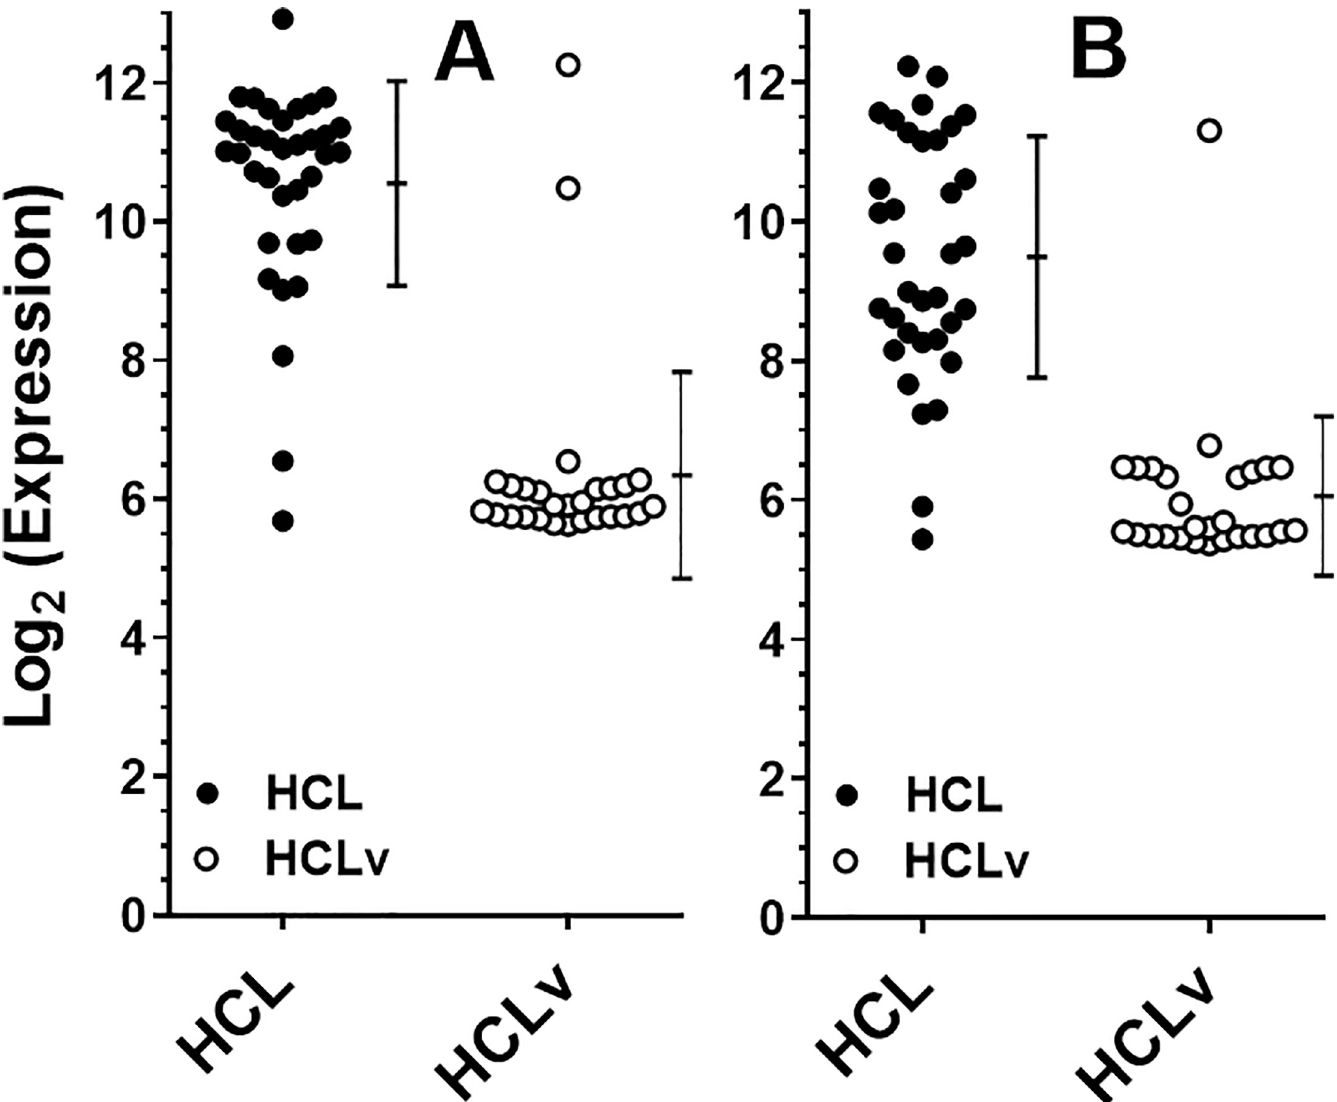
Fig 1. Microarray expression of Myf6 in HCL ( ● ) and HCLv ( � ) assessed by probe 1805802 (A) and probe 2157717 (B). Error bars indicates standard deviations around the mean.